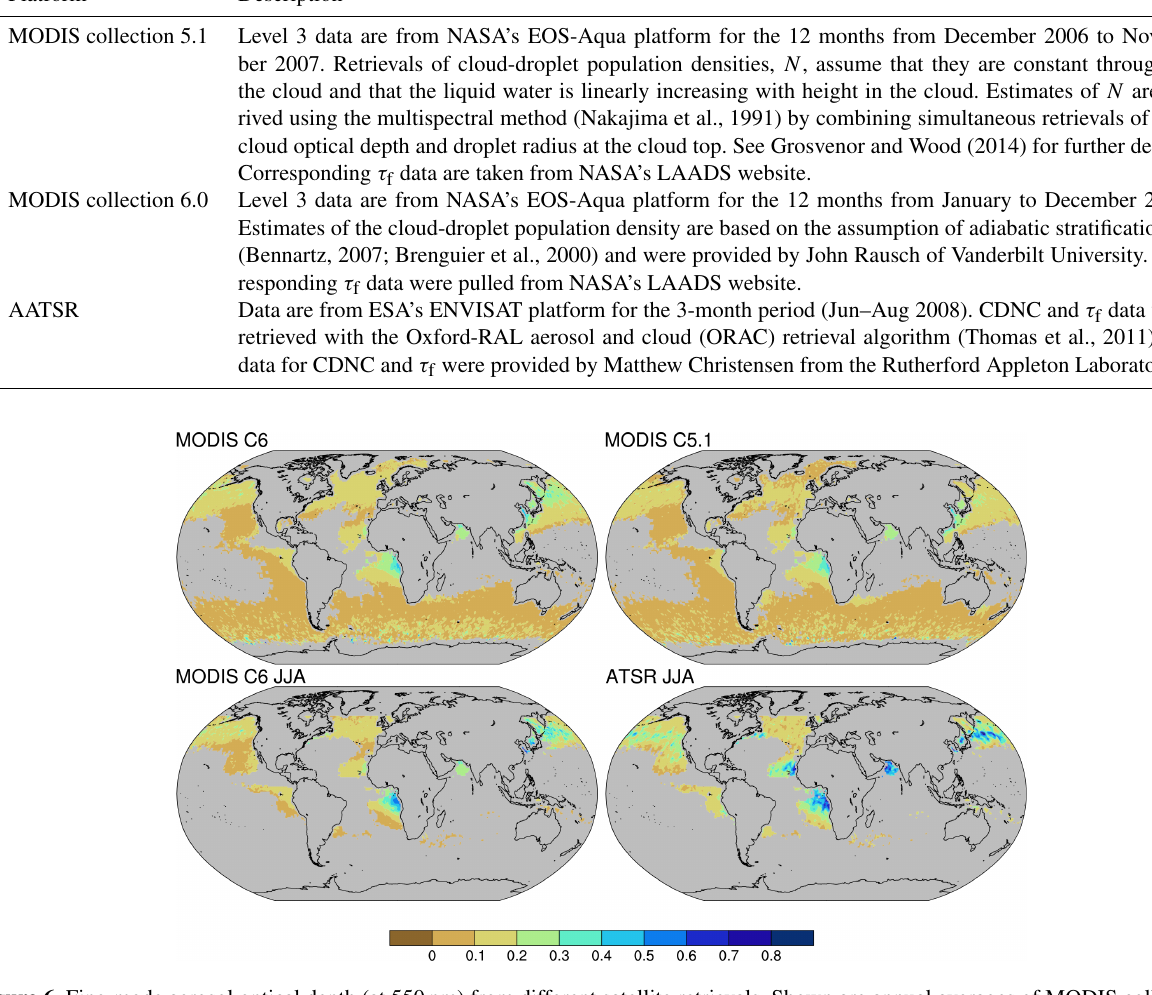
Figure 6. Fine-mode aerosol optical depth (at 550nm) from different satellite retrievals. Shown are annual averages of MODIS collection 6 for 2008 (upper left), MODIS collection 5.1 for 2007 (upper right); boreal summer (JJA) 2008 averages of MODIS collection 6 (lower left) and boreal summer (JJA) for AATSR-ORAC (lower right). Grey indicates no